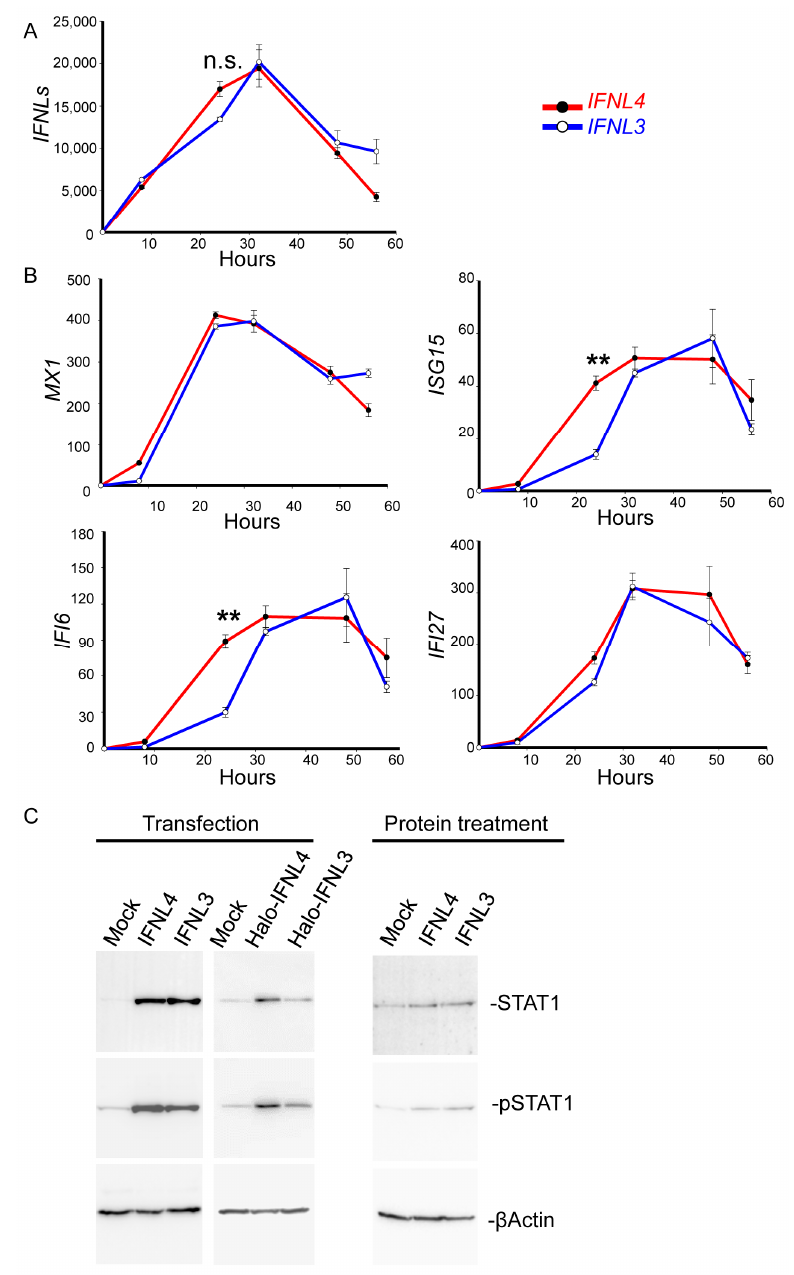
(Figure 2A). The data showed the same levels of IFNL3 and IFNL4 mRNA at 8, 32 and 48 h; at 24 h we observed somewhat higher IFNL4 expression in IFNL4-transfected cells when compared to IFNL3-transfected cells. Both interferons reached their highest expression levels at 32 h after transfection.